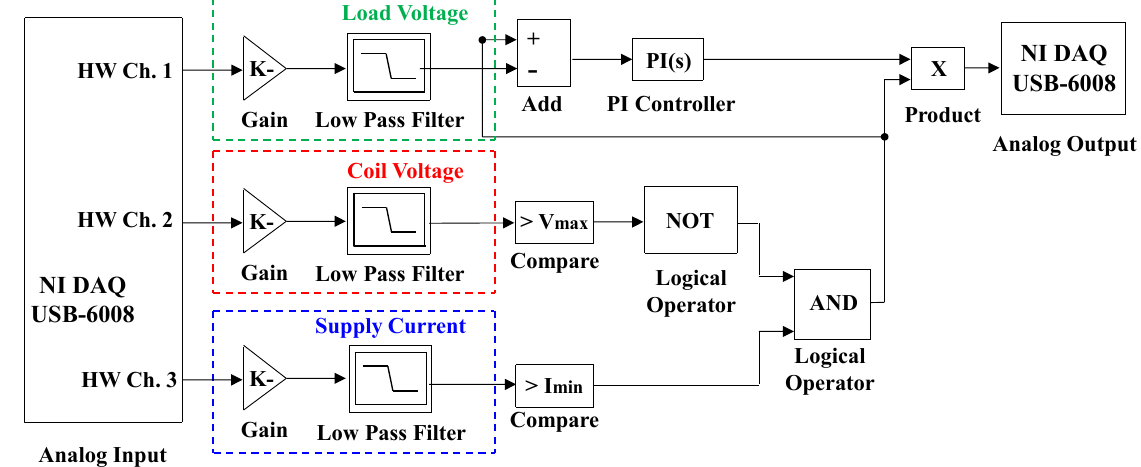
Figure 9. MATLAB/Simulink code for stabilizing receiver’s output